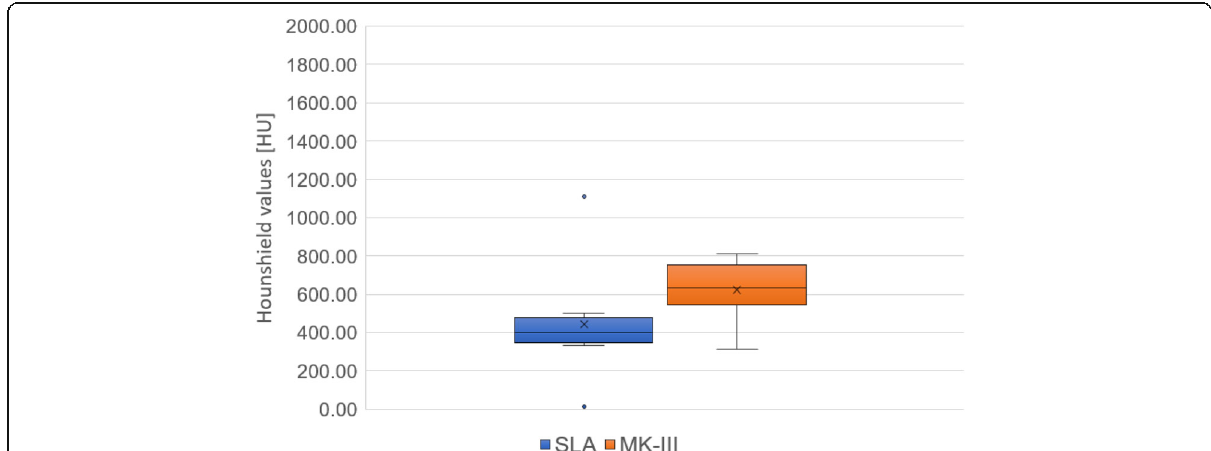
Fig. 5 Cancellous bone densities in SLA and MK-III implants within the abnormal group. The cancellous bone density shows no significant difference between SLA and MK-III implants at